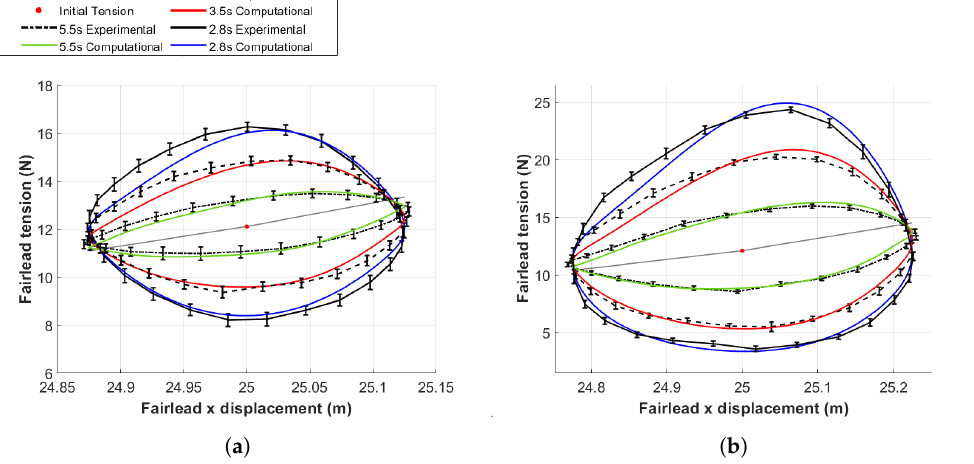
Figure 22. Comparison between the computed fairlead tension values and the experimental measure- ments of the mooring line with the clumped weight in configuration 1 for two different oscillation amplitudes A = 0.125, 0.225 m and three different periods T = 2.8, 3.5, 5.5 s for the isolated mooring line. ( a ) A = 0.125 m. ( b ) A = 0.225